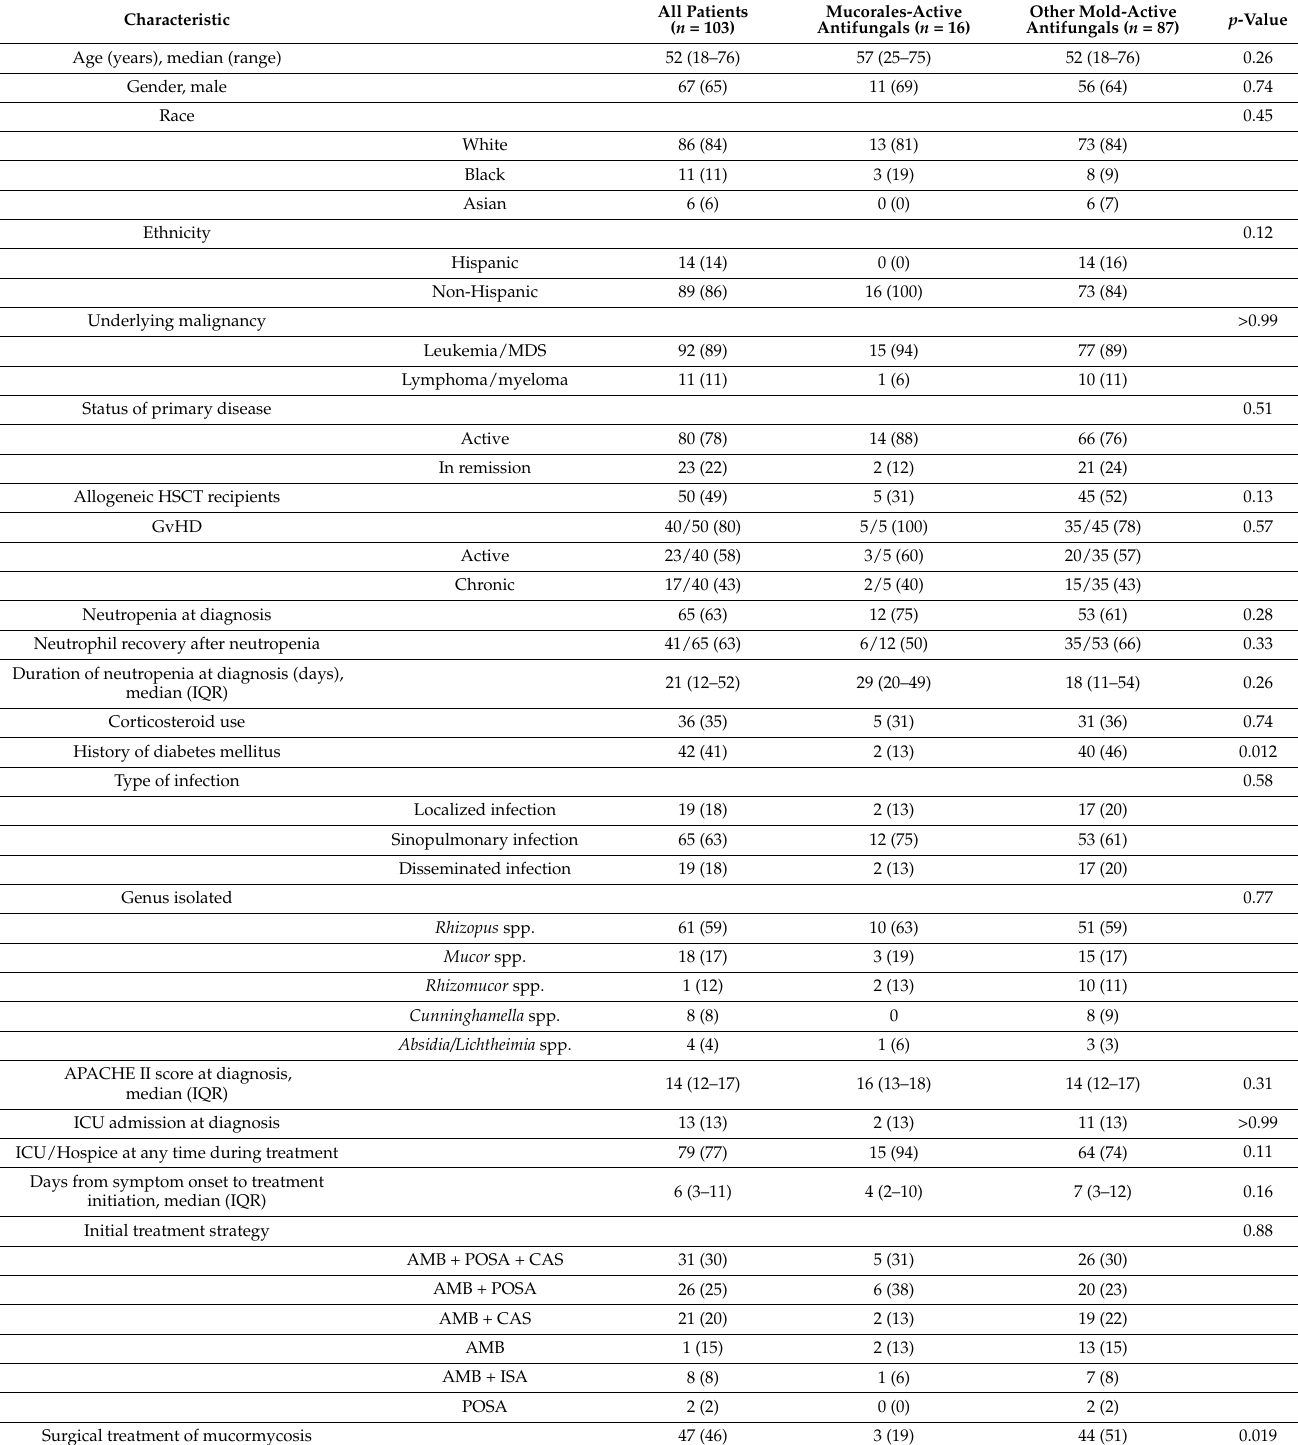
Table 1. Characteristics of patients with breakthrough mucormycosis (BT-MCR) on Mucorales-active versus other mold- active antifungals. Unless specified otherwise in the “characteristic” column, the number of patients and percentage (in parentheses) are